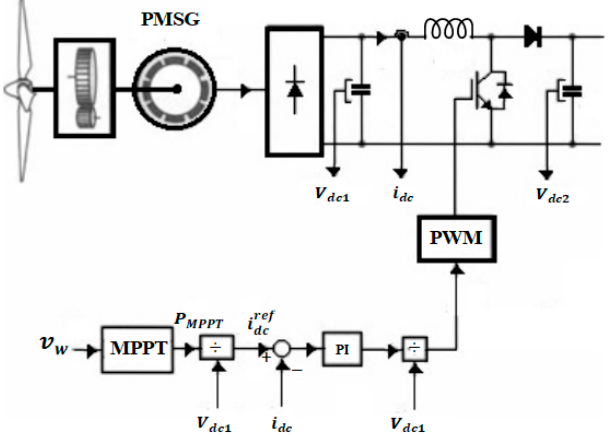
Figure 6. Control design for the wind turbine (WT) generator. PMSG: permanent magnet synchronous generator; MPPT: maximum power point